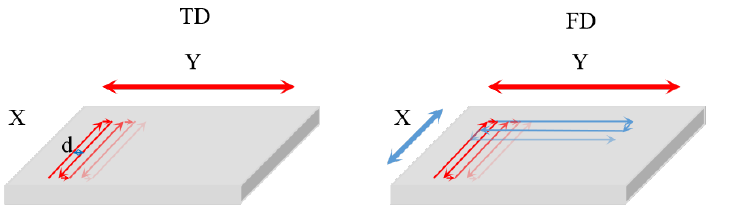
Figure 2. Schematic diagrams of two laser scanning patterns employed during milling of quartz samples; d is the distance between two consecutive scanning